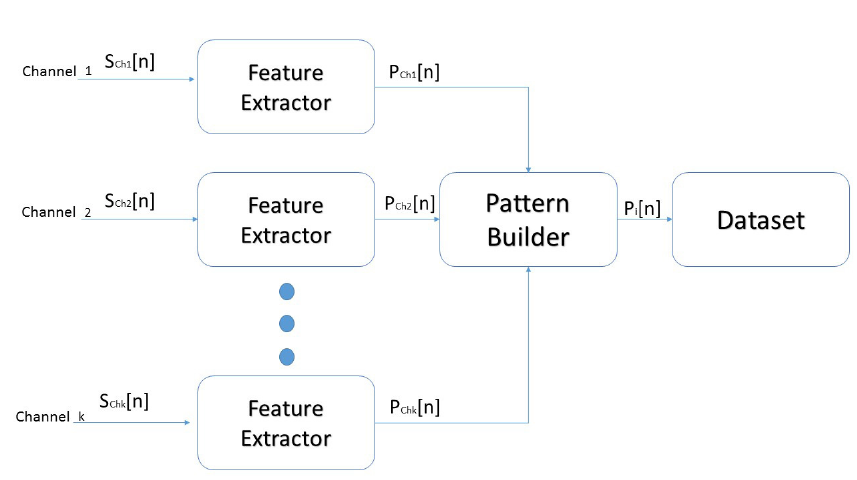
Figure 2. Dataset building block